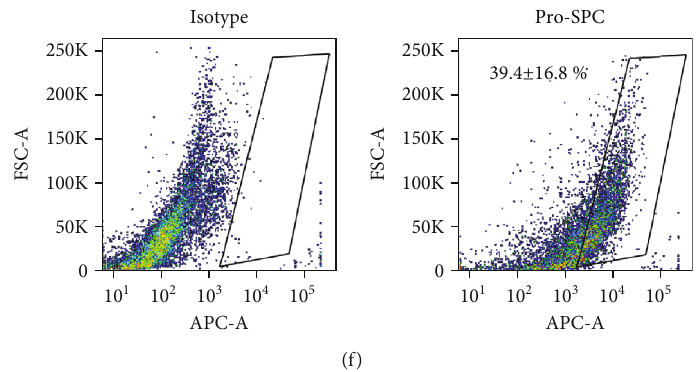
Figure 5: (a) Di ff erentiation protocols for maintaining ATII and removal of residual undi ff erentiated iPSCs by JQ1. (b) Quantitative polymerase chain reaction analysis ( n = 4 ). Expressions of Sftpc and Sftpb mRNA. Expression ratios were normalized to the level of Gapdh expression. Expression levels were compared with those on day 26. ∗ P < 0 : 05 . Three cell groups, day 26, day 40/JQ1(-), and day 40/JQ1(+), were compared. (c) Phase-contrast image and immuno fl uorescence images of pro-SPC and pro-/mature SPB on day 40. Scale bars: 70 μ m. (d) Phase-contrast and fl uorescence images of Nanog-GFP on day 40. Nanog-GFP-positive cells were decreased in the JQ1- administered group (day 40/JQ1(+)). Scale bars: 100 μ m. (e) Transmission electron microscopy of di ff erentiated ATII on day 40. Lamellar body-like structures were observed (arrowheads). Scale bar: 2 μ m. (f) Flow cytometry analysis of pro-SPC on day